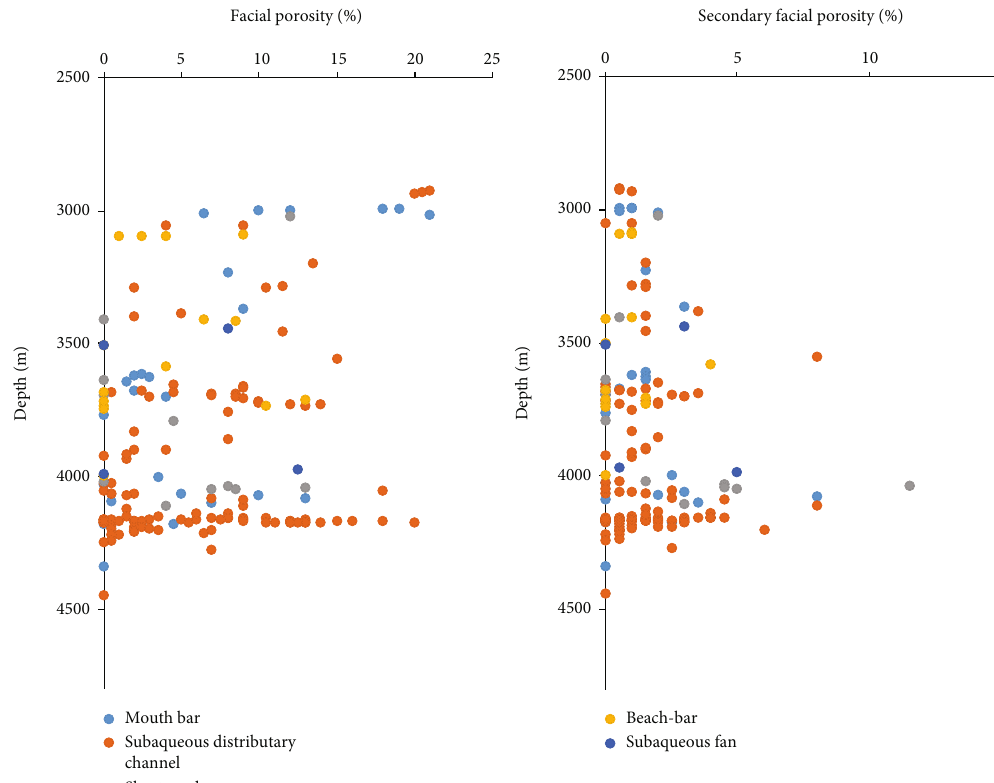
Figure 19: The vertical distribution of facial porosity and secondary facial porosity with di ff erent depositional facies.